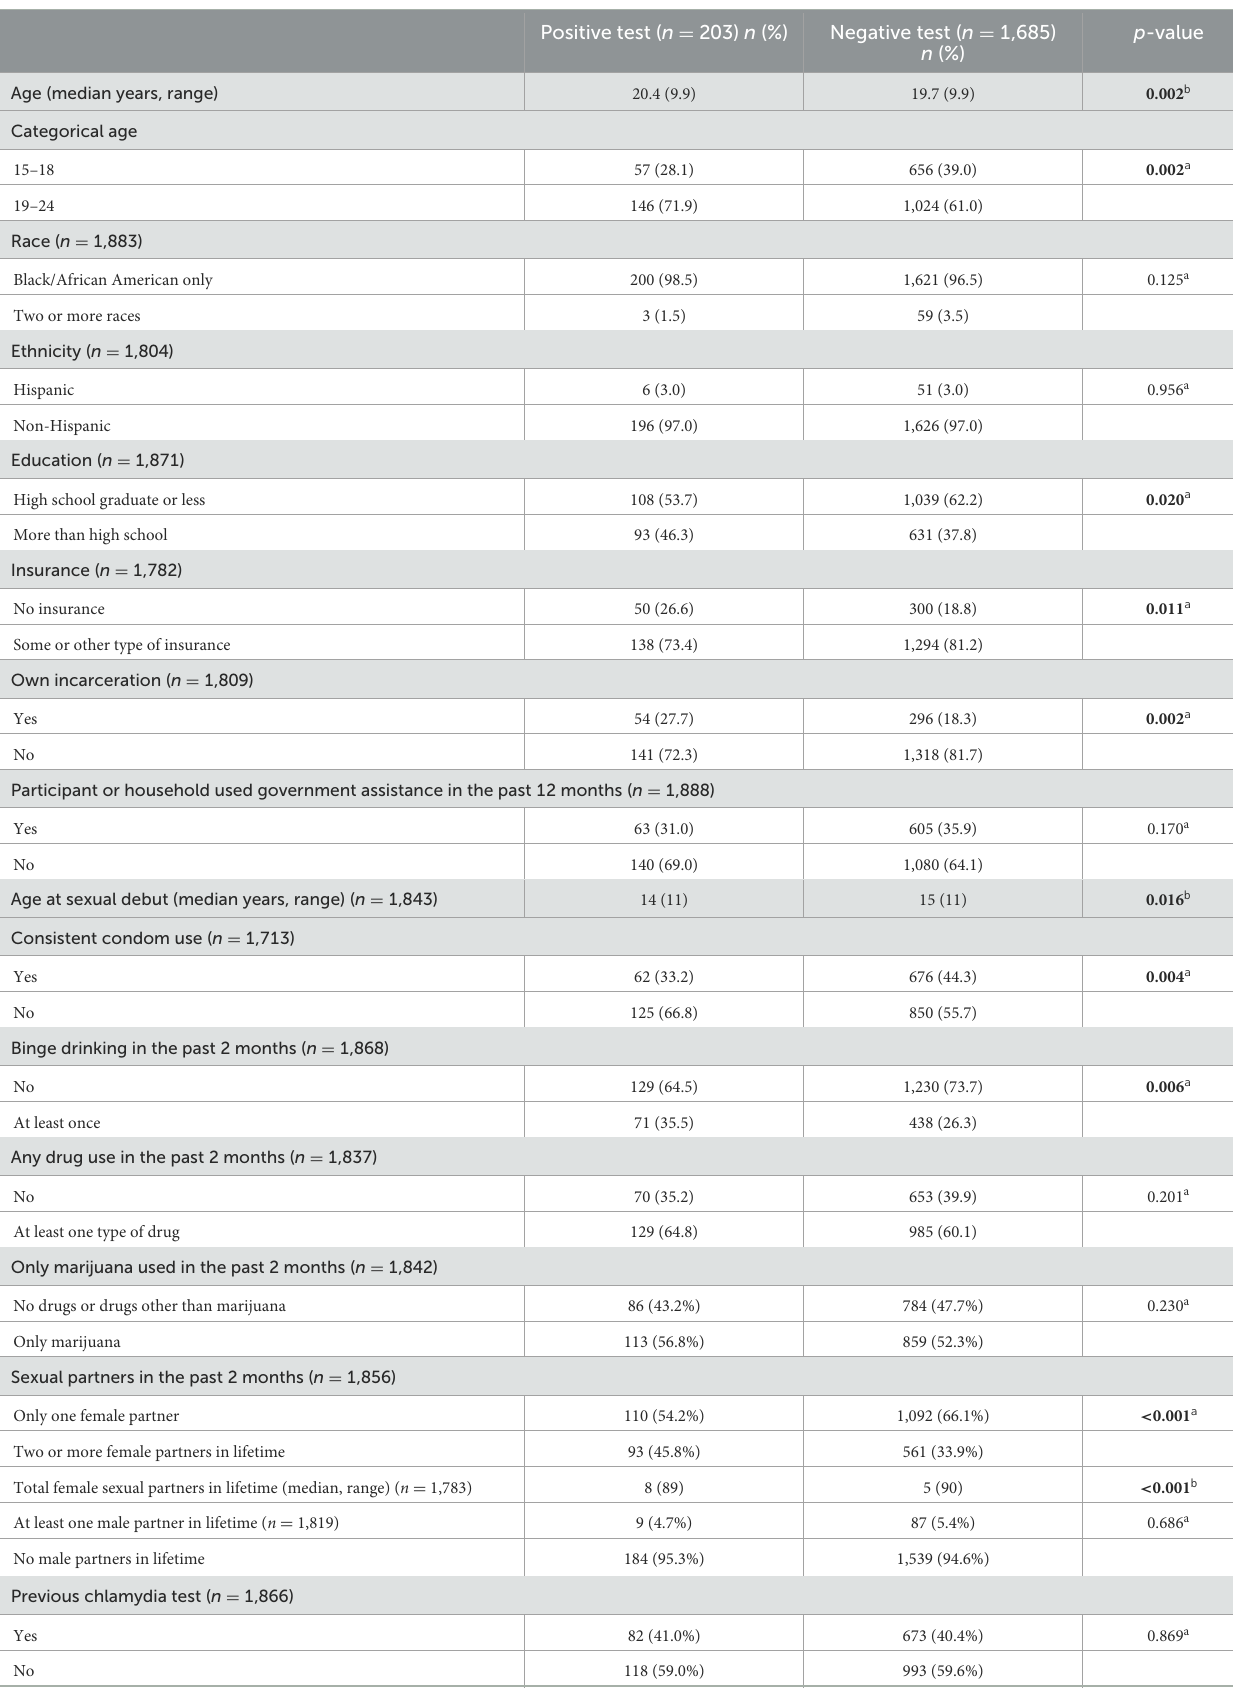
TABLE 3 Characteristics by chlamydia test results ( n =